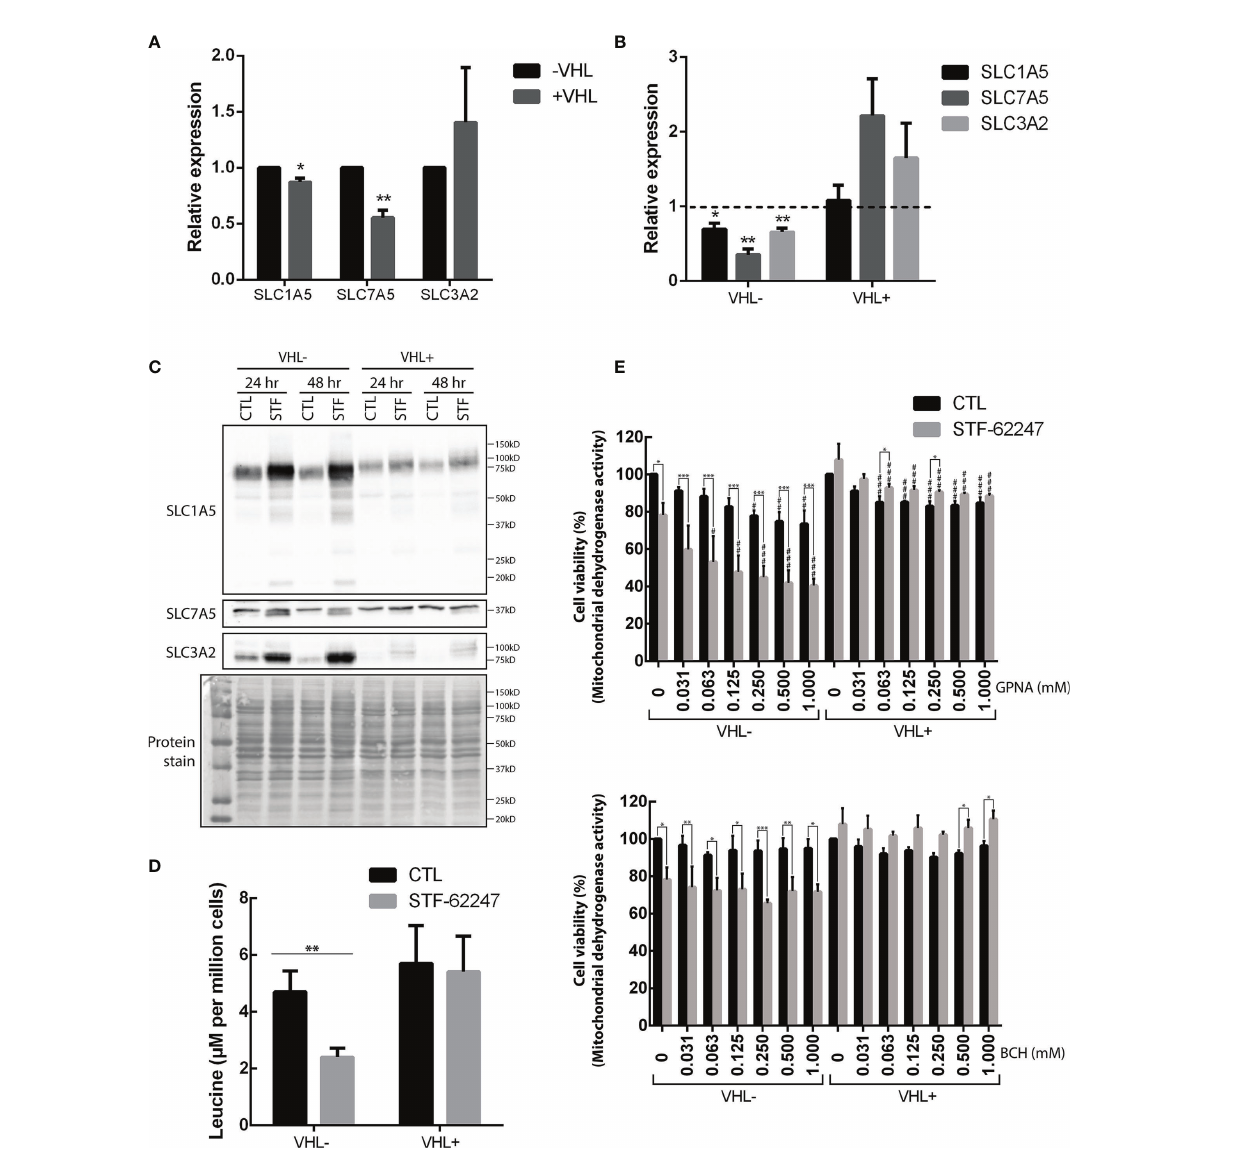
FIGURE 2 | Effects of STF-62247 on glutamine transporters. (A, B) mRNA relative expression, measured by RT-qPCR, of glutamine transporters SLC1A5, SLC7A5 and SLC3A2 in fl uenced by (A) VHL status and (B) STF-62247. RCC4 VHL- and VHL+ were treated with 1.25 µM STF-62447 for 24 hr. Results for treated cells are compared to control cells (represented by the dotted line at 1). Results are presented as means and SEM of three independent experiments. (C) Glutamine transporters, SLC1A5, SL7A5 and SLC3A2, protein levels in RCC4 VHL- and VHL+ treated to STF-62247 for 24 and 48 hr. (D) Intracellular leucine was measured by LC-MS in RCC4 VHL- and VHL+ treated with 1.25 µM STF-62247 for 24 hr (N=6). Student ’ s t -tests were performed to compare results between VHL- and VHL+ cells (A) or between controls and treated cells (B, D) (*p < 0.05, **p < 0.01, ***p < 0.001). (E) Cell viability was evaluated by XTT assay in RCC4 VHL- and VHL+ cells. SLC1A5 and SLC7A5 inhibitors, GPNA and BCH respectively, were tested alone (concentrations from 0 to 1 mM) or combined with 1.25 µM STF-62247 (N=3). Two-Way ANOVA followed by Tukey ’ s test was performed to assess statistically signi fi cant results. Comparison between CTL and STF-62247 conditions for each concentration of inhibitor (GPNA or BCH) are denoted with the following statistical marks *p < 0.05, **p < 0.01 or ***p < 0.001. Comparison of each inhibitor concentrations (x-axis) are made with their respective control (0 mM columns, with or without STF-62247) and statistical signi fi cances are denoted by # p < 0.05, ## p < 0.01 or ### p <